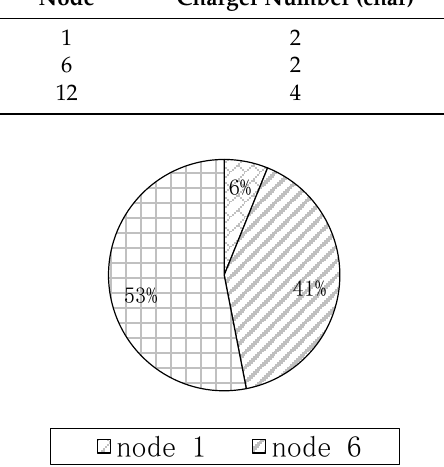
Figure 13. Percentages of the frequencies of each charging station selected.